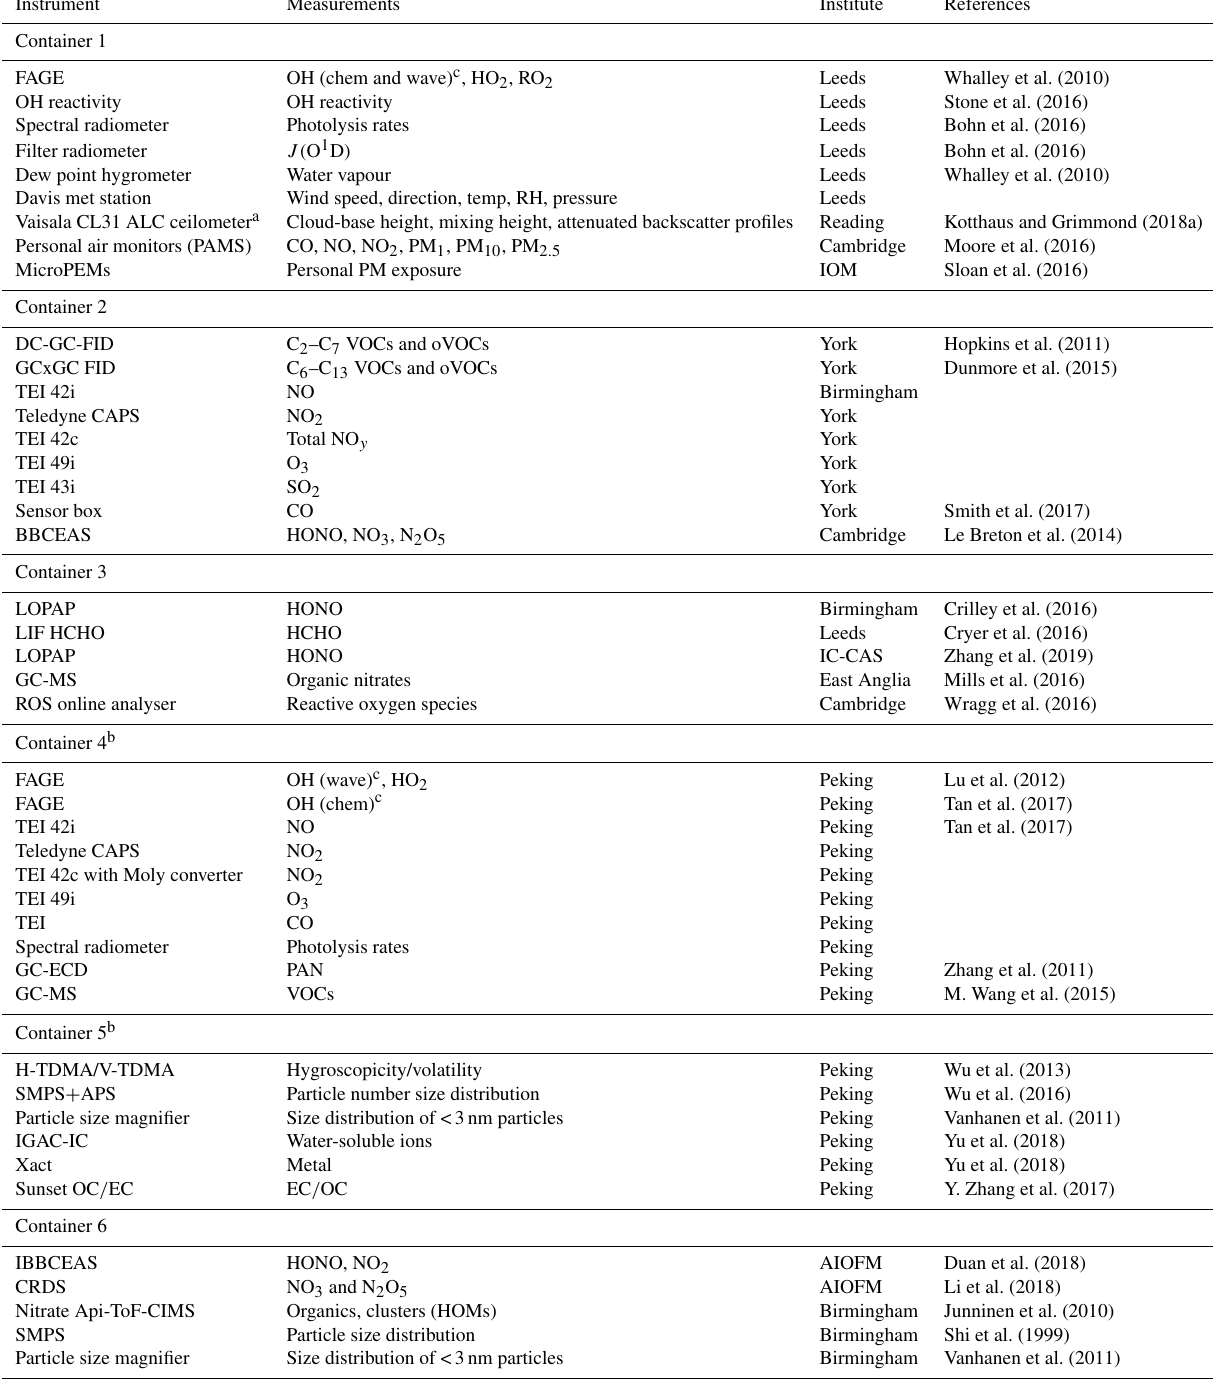
Table 1. Overview of measurements in APHH-Beijing at the urban site.